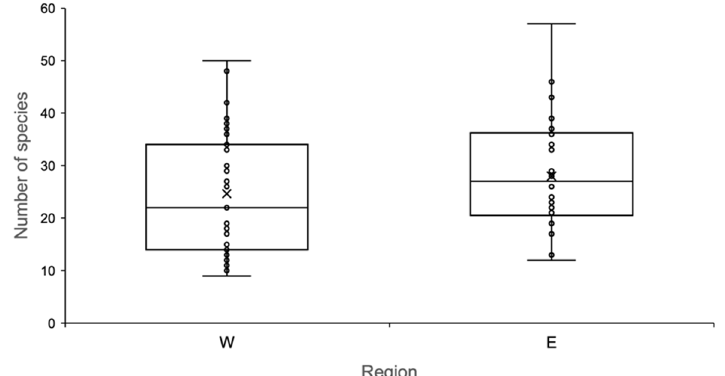
Figure 2. Box plots showing the average number of polychaete species and the minima and maxima values (whiskers) for the western (W) and eastern (E) regions of the Southern Gulf of Mexico.